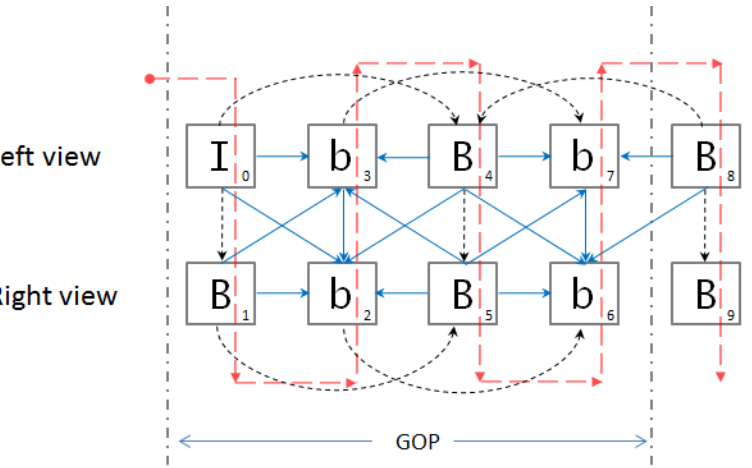
Figure 2 . Reference frame architecture of the proposed HEVC-FISMVC for stereo videos. Figure 2. Reference frame architecture of the proposed HEVC-FISMVC for stereo videos.